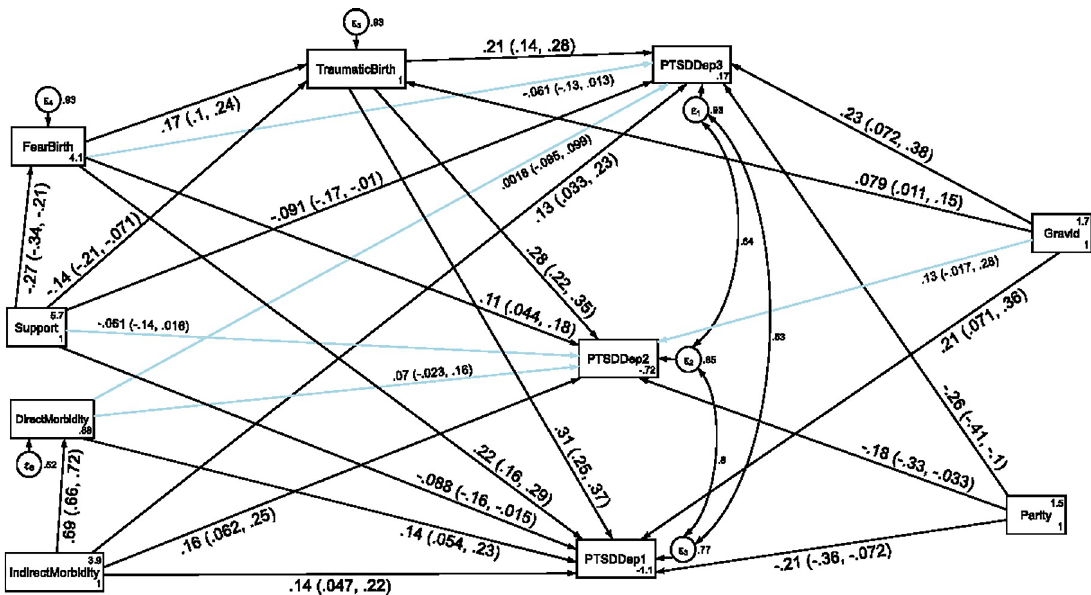
Fig 8. A structural equation model of the factors associated with comorbidity of depression and PTSD symptoms in postpartum women, Northwest Ethiopia. Note: β ’s are standardized estimates with 95%